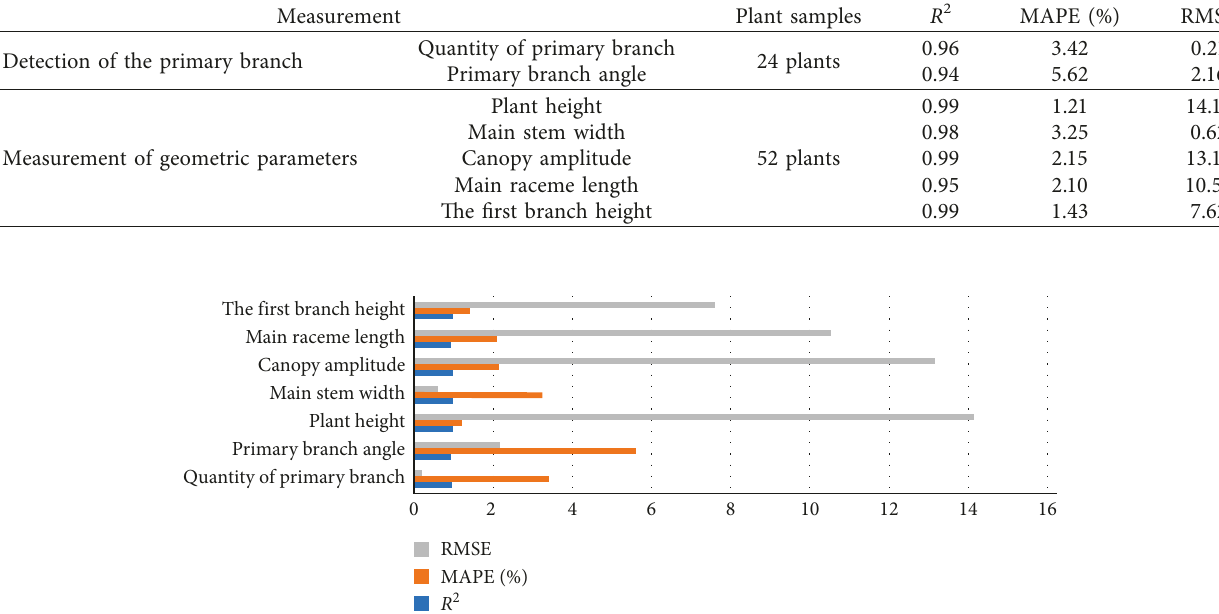
Table 1: The results of the system evaluation.